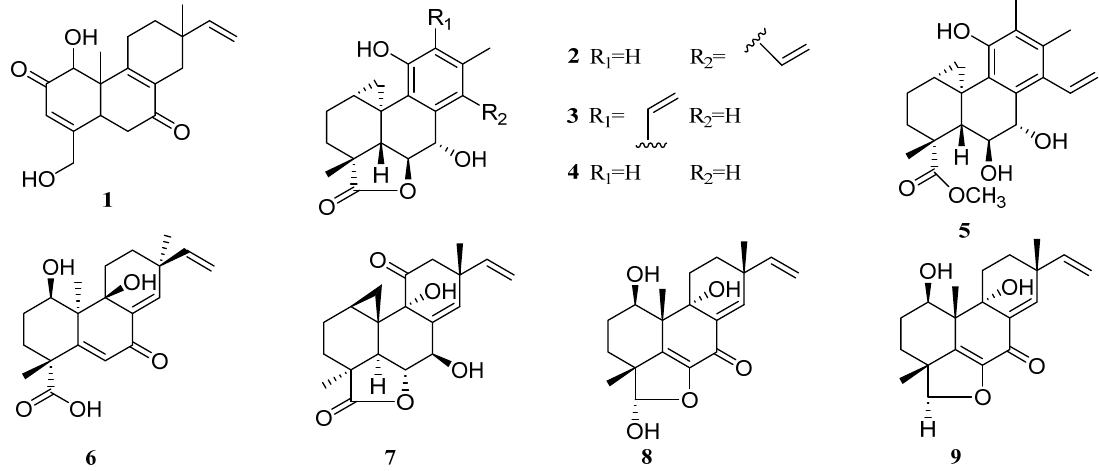
Figure 4. Chemical structures of diterpenes ( 1 from Actinomadura sp., 2 – 9 from Arthrinium sp.).